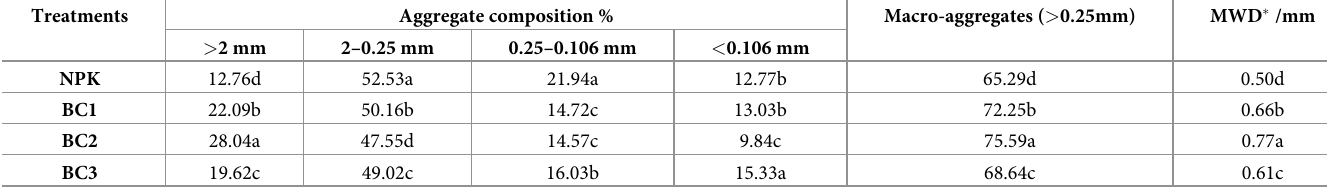
Table 4. Composition and stability indexes of black soil aggregates for different biochar treatments.